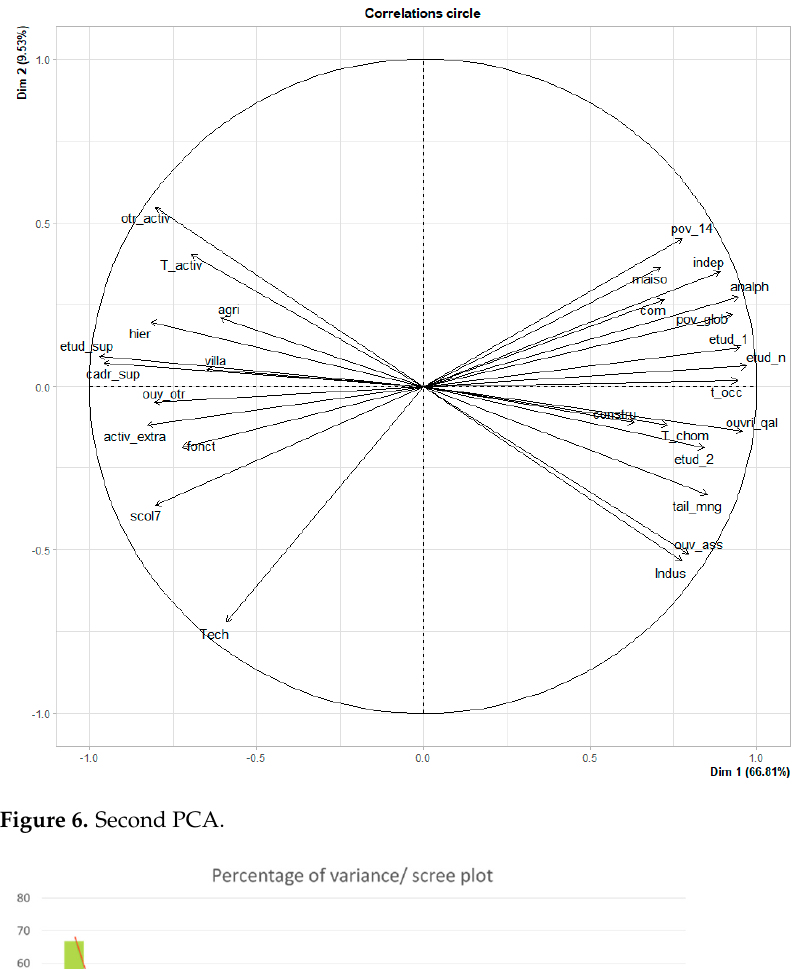
Figure 6. Second PCA.